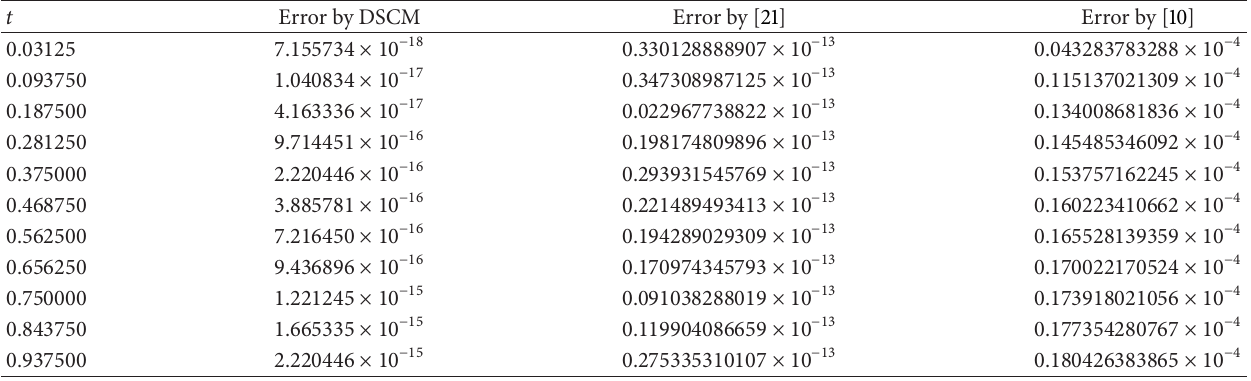
Table 2: The absolute errors of DSCM ( 𝜙 1 = 0.9, 𝜙 2 = 0.98 ) and the methods reported in [10, 21]; 𝛼 = 0.75